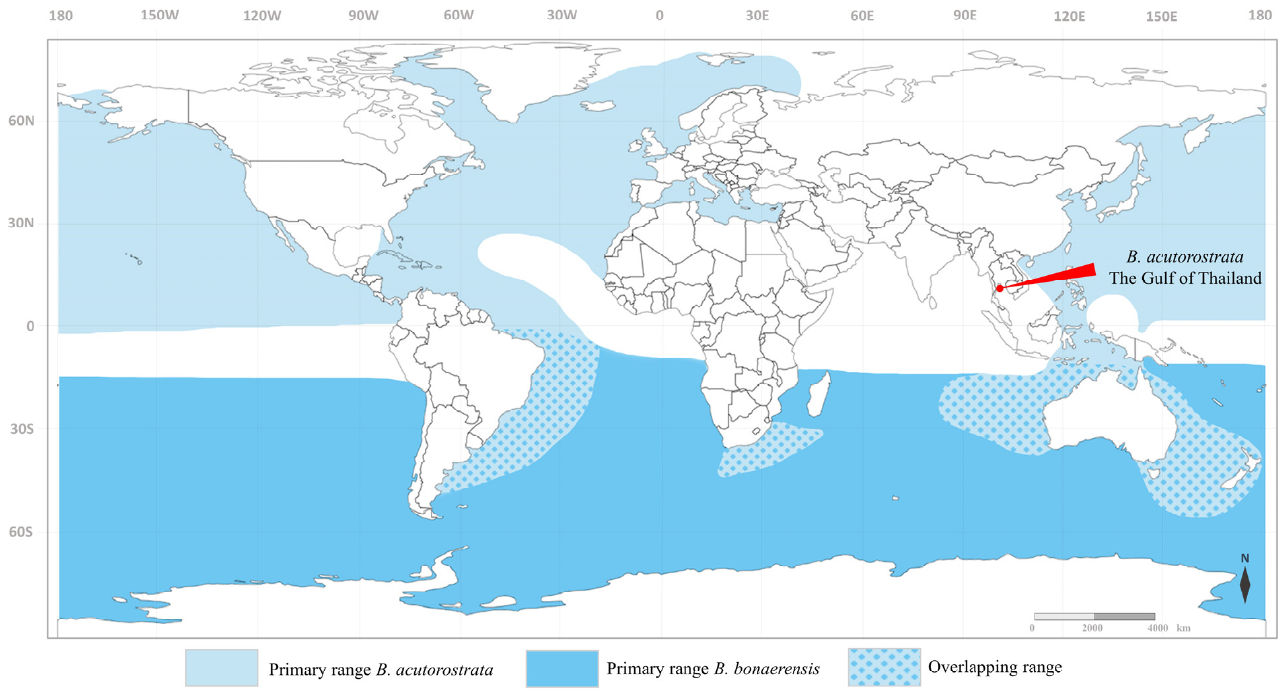
Figure 1. Map showing the stranding site of Balaenoptera acutorostrata in the Gulf of Thailand and the normal distribution range of B. acutorostrata and B. boenarensis in the world’s oceans. The tissues of non-decomposed organs were collected, with muscle tissue preserved in 95% ethanol for DNA extraction according to the manufacturer’s instructions (DNeasy Blood & Tissue Kit, QIAGEN, Hilden, Germany). The extracted DNA, diluted to 50 ng/ µ L, was measured qualitatively and quantitatively using 2% agarose gel electrophoresis and absorbance at A260. The D-loop was chosen as a marker for identifying the